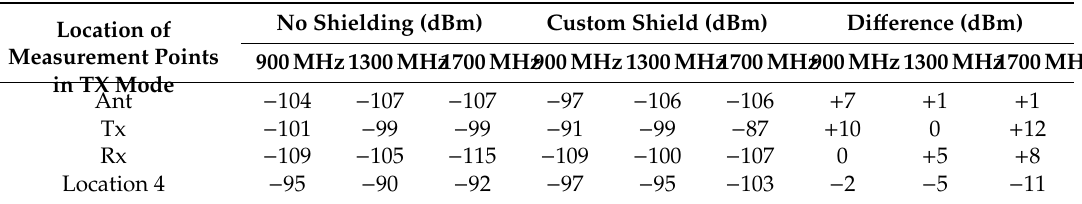
Figure 9. SolidWorks 3D rendering of the switch amplifier housing with four measurement sites. Table 3. Average transmission network (Tx) mode leakage signal measurements at designated locations for 900, 1300, and 1700 MHz, respectively.